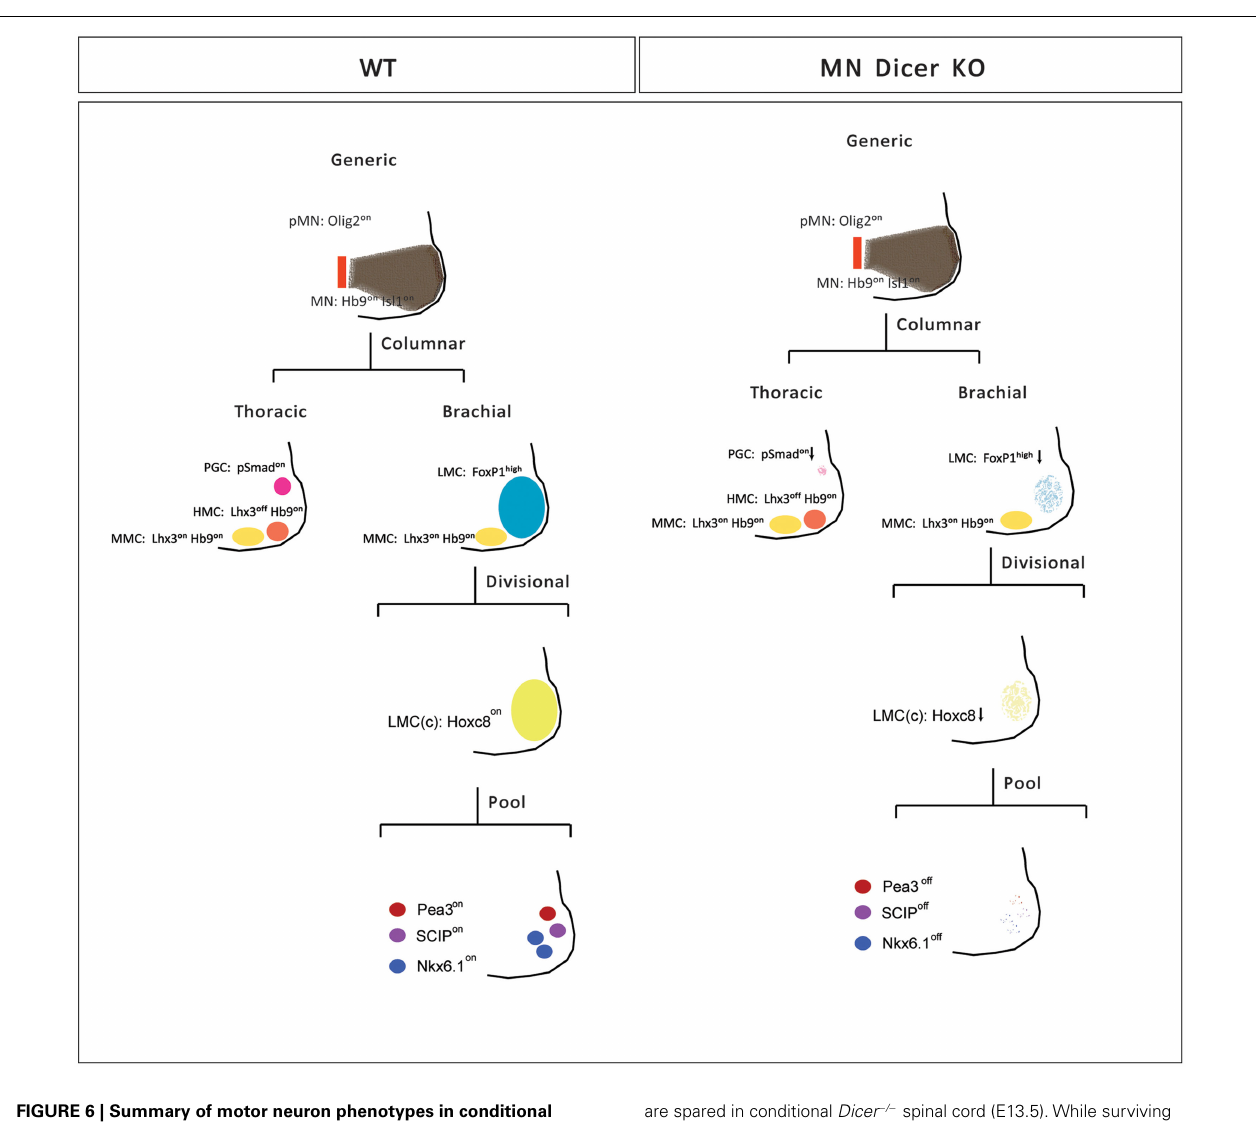
FIGURE 6 | Summary of motor neuron phenotypes in conditional Dicer KO embryos. Initial specification of pMN and nascent postmitotic generic motor neurons is not affected in conditional Dicer − / − embryos (E11.5). Subsequently, motor neurons occupying different motor columns respond differentially to the loss of Dicer activity.The numbers of PGC and LMC motor neurons are reduced whereas HMC and MMC neurons